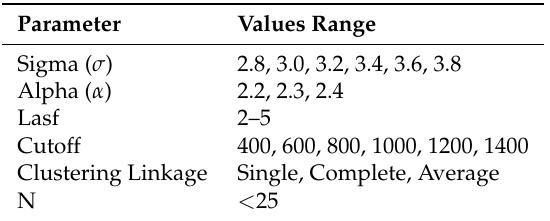
Table 3. Various parameters and their range